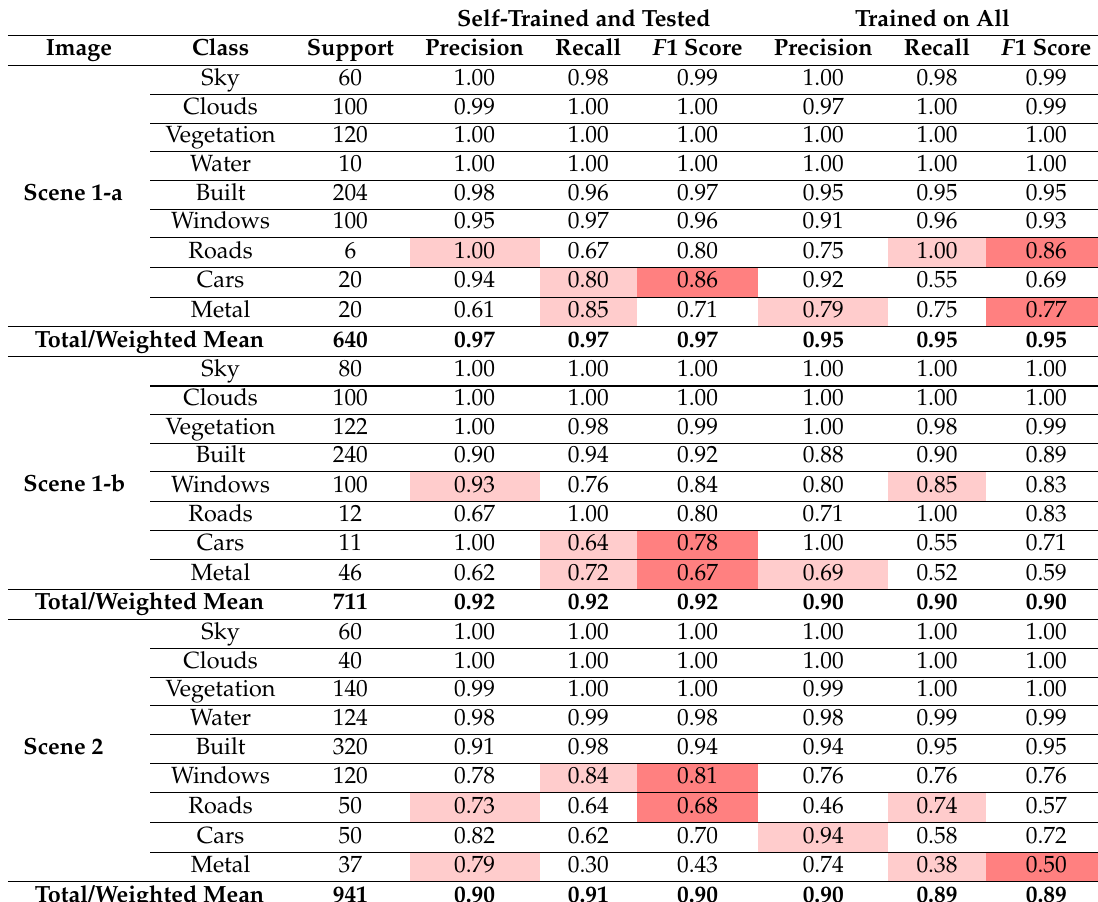
Table 3. Performance metrics of CNN Model 2 trained and tested on each of the three scenes in Figure 1 separately as opposed to CNN Model 2 trained on all scenes simultaneously. These metrics were computed from the confusion matrices provided in Appendix A Figure A3. The cell highlighting is described in Table 1. Overall, the two model variants (self-trained and all-trained) performed similarly in each scene, with the self-trained models marginally outperforming the all-trained model. In particular, both variants performed equally at classifying natural materials, but the self-trained models more accurately classified human-built